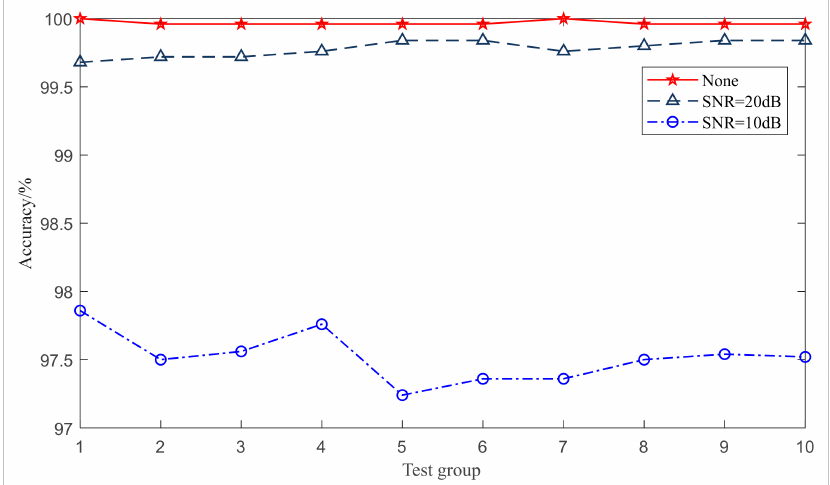
Figure 10. Testing the accuracy of MDI-CNN after incremental